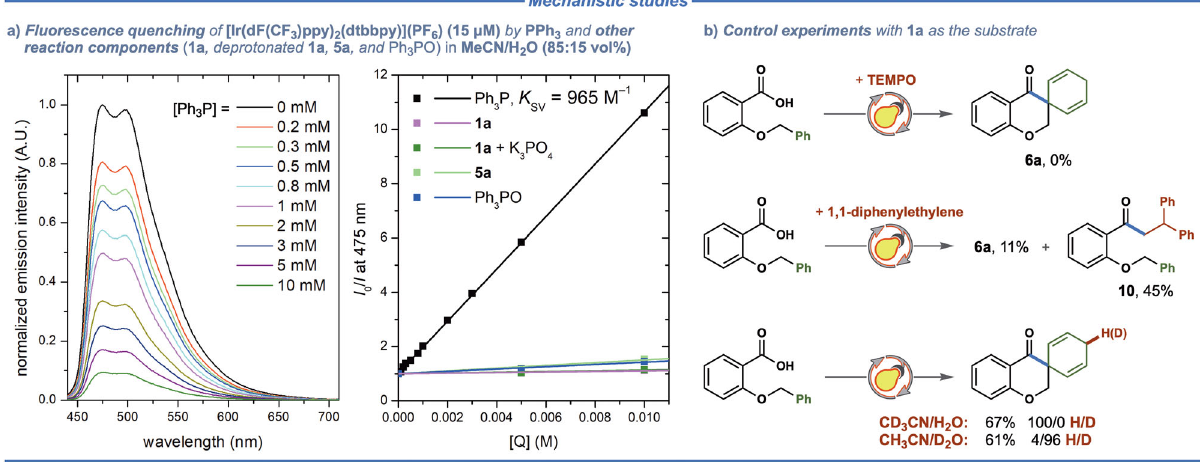
Fig. 4 Mechanistic studies. a Fluorescence quenching of [Ir(dF(CF 3 )ppy) 2 (dtbbpy)](PF 6 ) (15 µ M) by PPh 3 and other reaction components ( 1a , deprotonated 1a , 5a , and Ph 3 PO) in MeCN/H 2 O (85:15 vol%). b Control experiments with substrate 1a with radical traps (TEMPO and 1,1- diphenylethylene) and different deuterated